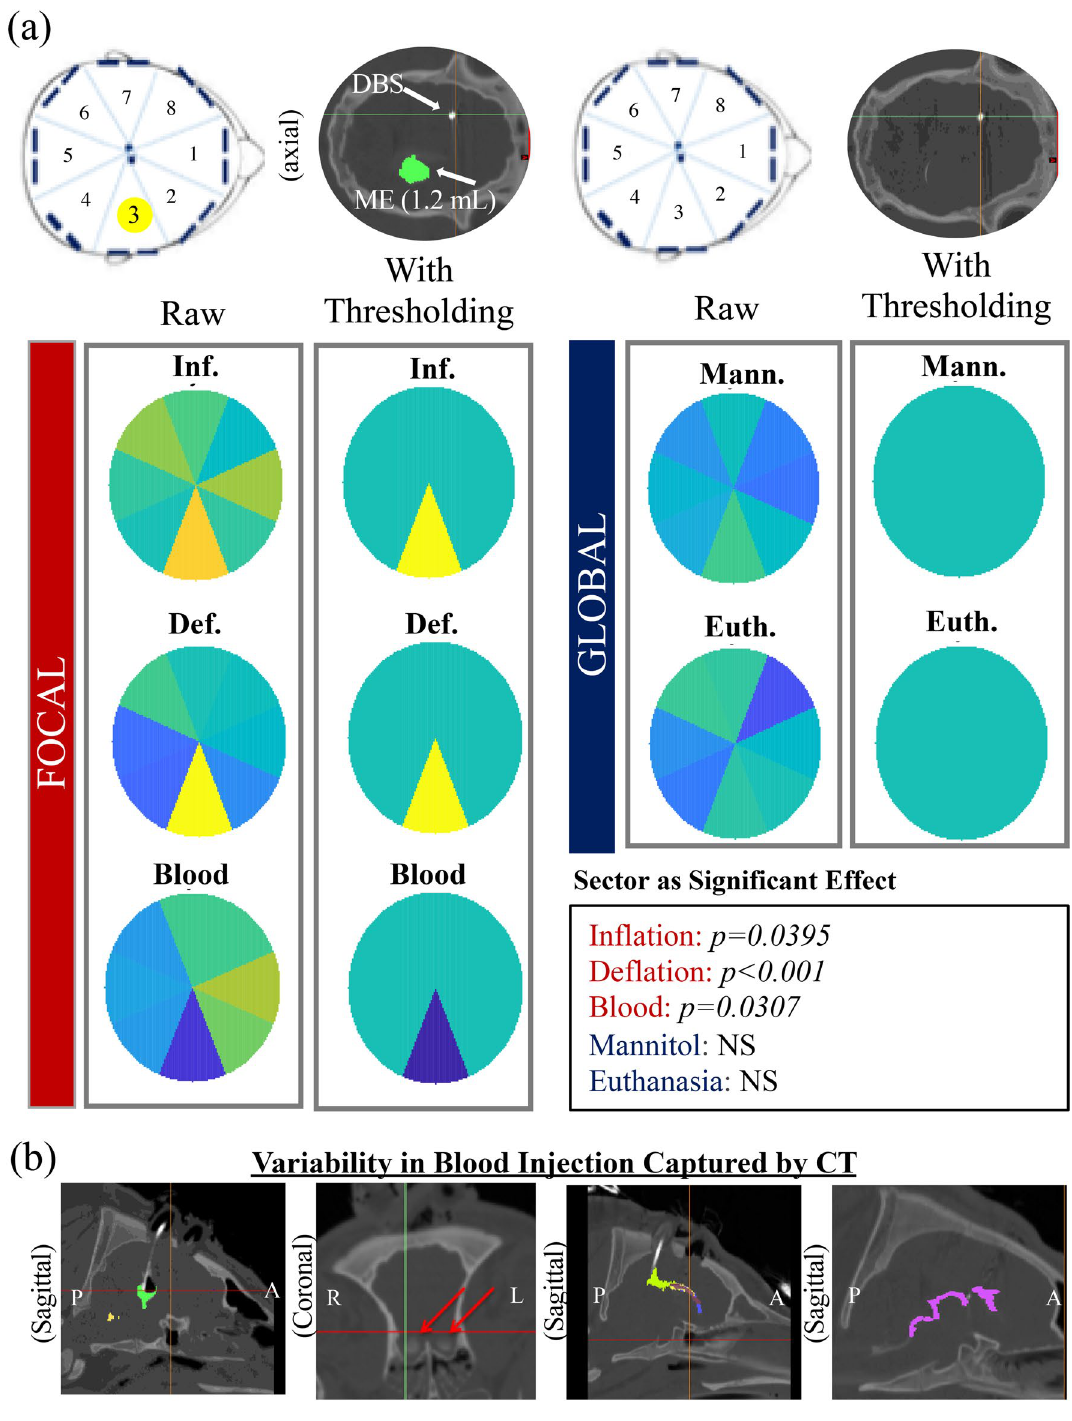
Figure 6. Localization between focal and global events. ( a ) Colormaps of normalized change in impedance (nΔZ) for each event across all pigs (caxis: 0–1). Raw maps show the mean nΔZ for all elements, while threshold maps display a discrete differentiation between both focal and global events and between ischemic 1 and hemorrhagic injuries. A threshold approach was heuristically determined with thresholds of nΔZ < 3 2 and nΔZ > 3 . Should any element satisfy one of these thresholds, the binary map identifies the minimum or maximum element as the discrete focal injury element for hemorrhage or model ischemia, respectively. Any 1 n � Z < 2 event with all nΔZ values between 3 < 3 were categorized as global. Inclusion was located in Element 3. Only focal events presented an element’s ‘sector’ as a significant effect in a mixed model. ( b ) Display of some of the variabilities present in the hematoma model captured by the CT scan, competing with focal localization ability. From left to right: induced air during blood injection, pooling of blood in the olfactory ventricles (unique to pigs), anterior blood tracking, posterior ventricular tracking down to the spinal cord (most